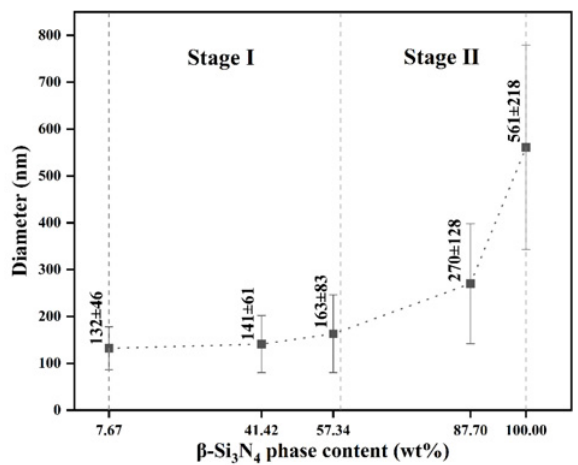
Fig. 4 Average grain sizes of monolithic Si 3 N 4 ceramics with different β -Si 3 N 4 phase contents.